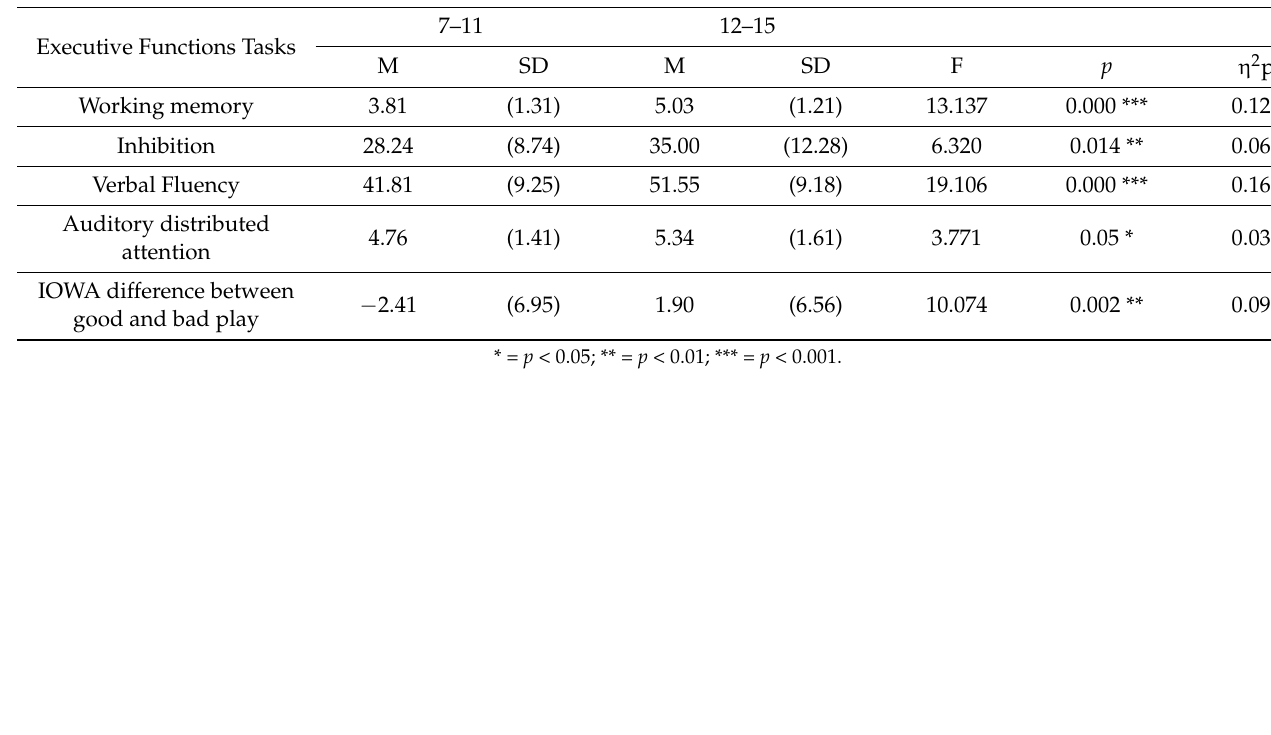
Table 2. Means, standard deviations, and ANOVA results for EFs tasks stratified by age. Executive Functions